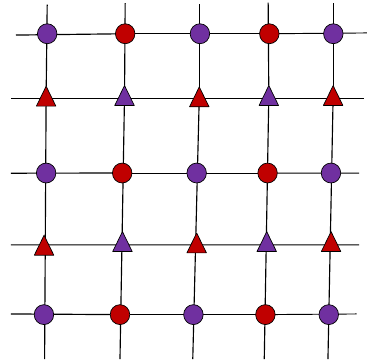
Figure 2. Disjoint domain decomposition.